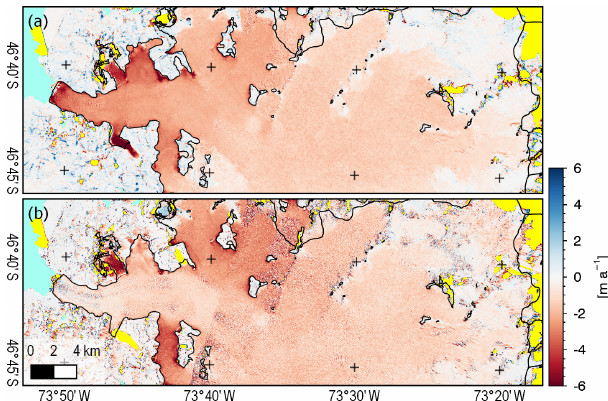
Figure 3. SECR of San Rafael: (a) 2000–2012, (b) 2012–2016. riods 18 December 2011 to 26 March 2012 (99 d), 7 Decem- ber 2011 to 15 March 2012 (99 d) and 29 December 2011